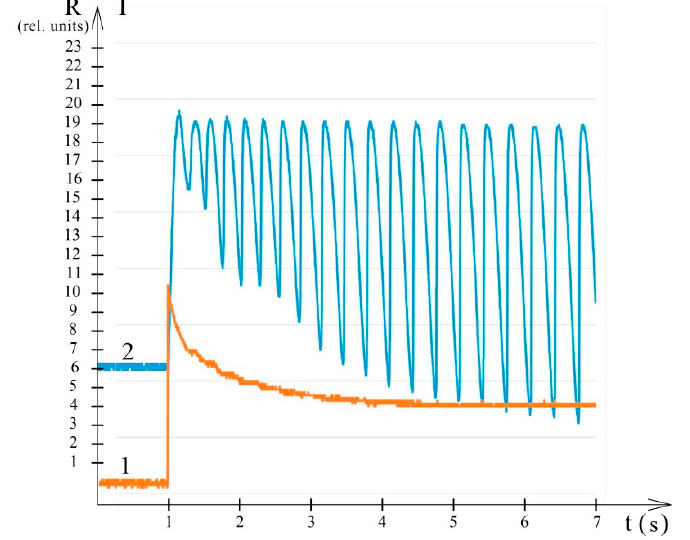
Figure 3. Plotted graph based on the oscillogram obtained by the GDS-71022 oscilloscope. Dependence of the reflection coefficient of the cell surface on time (optical response) during self-oscillations of the particle concentration in the liquid membrane. Beam 1—current passing through the cell; beam 2—periodic change in the intensity of reflected light (optical response).